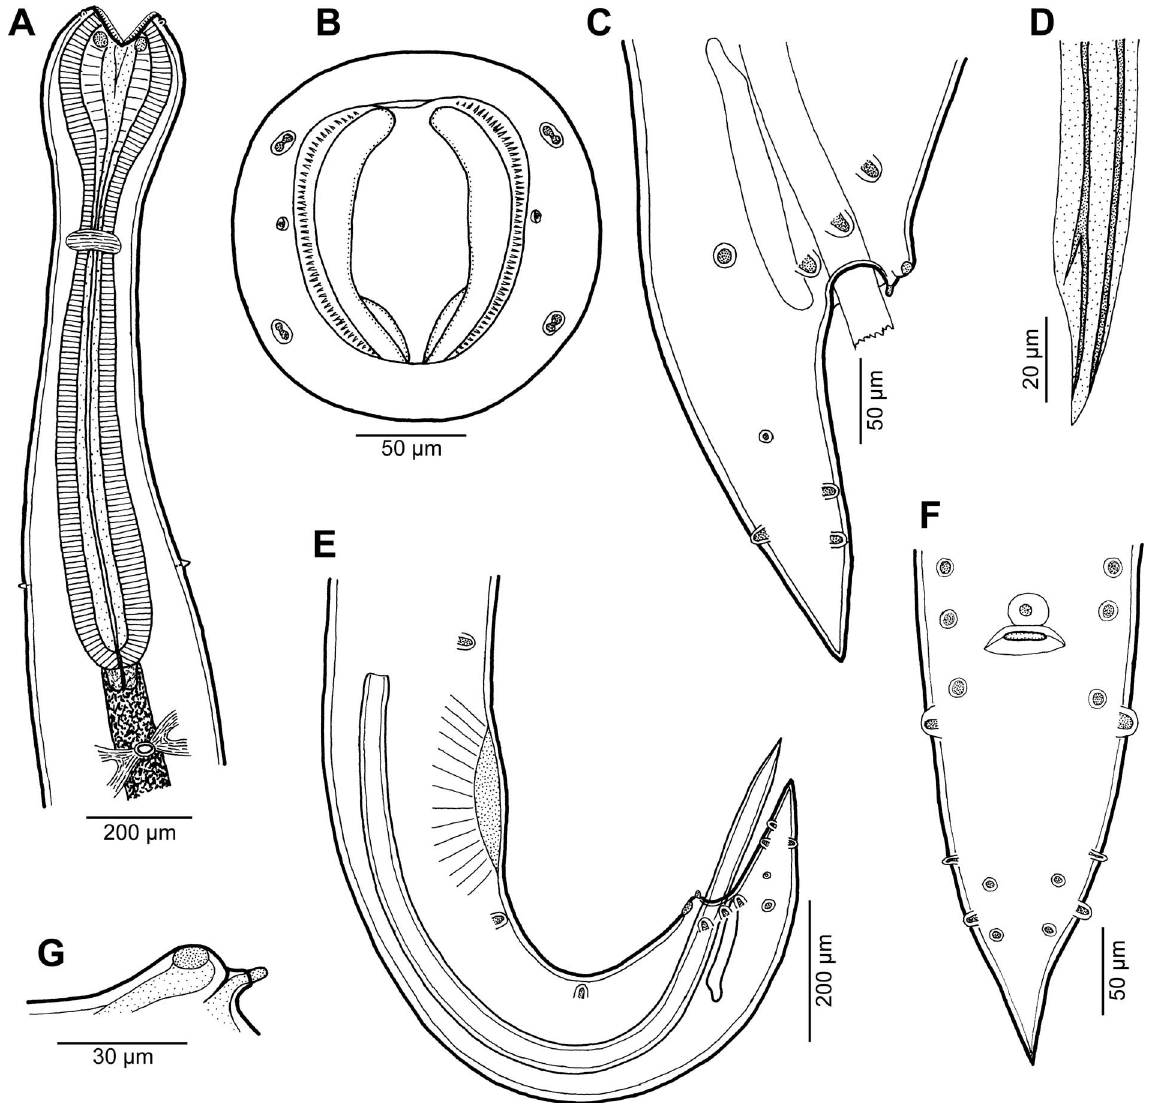
Figure 4. Cucullanus gymnothoracis n. sp. from Gymnothorax chilospilus , male. (A) Anterior end of body, ventral view; (B) cephalic end, apical view; (C) tail, lateral view; (D) distal end of spicule, lateral view; (E) posterior end of body, lateral view; (F) tail, ventral view; (G) median precloacal papilla-like formation and outgrowth of anterior cloacal lip, lateral